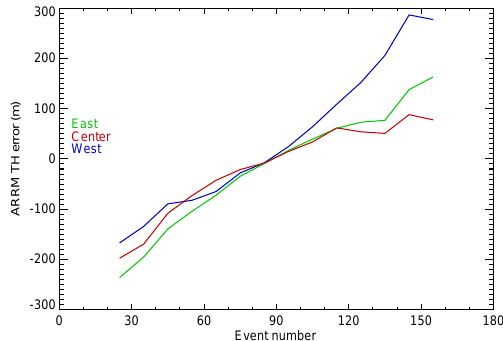
Figure 11. Average (over the ∼ 5-year study period) ARRM results by event number (green: east slit; red: center slit; blue: west slit). There appears to be an average 300–400m TH change over an